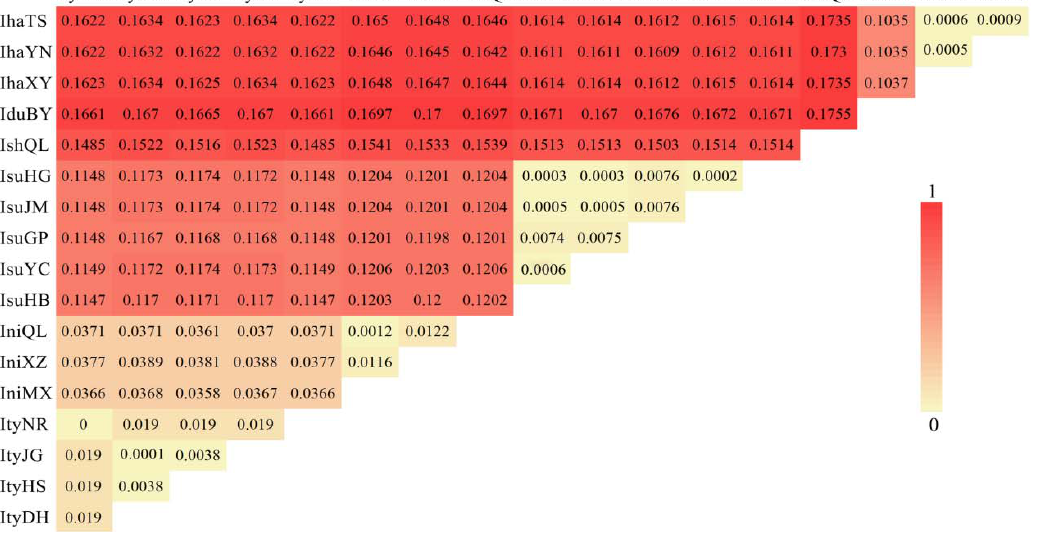
Figure 5. Genetic distance of the six Ips species (the deeper the red, the greater the genetic distance).